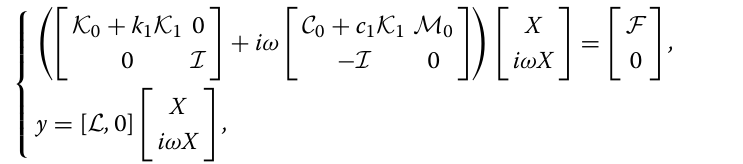
where K 0 and M 0 are obtained from a finite element model with 25,962 degrees of freedom, C 0 represents Rayleigh damping, K 1 is a matrix with four non-zero entries that represents the interaction between the tuned mass damper and the footbridge, the input vector F represents a unit excitation at the center span, and the output vector L picks out the vibration at the center span. The model has two parameters, the stiffness of the damper k 1 and the damping coefficient of the damper c 1 . To reduce the model, we apply the Krylov subspace method [33,34] on the first-order equivalent